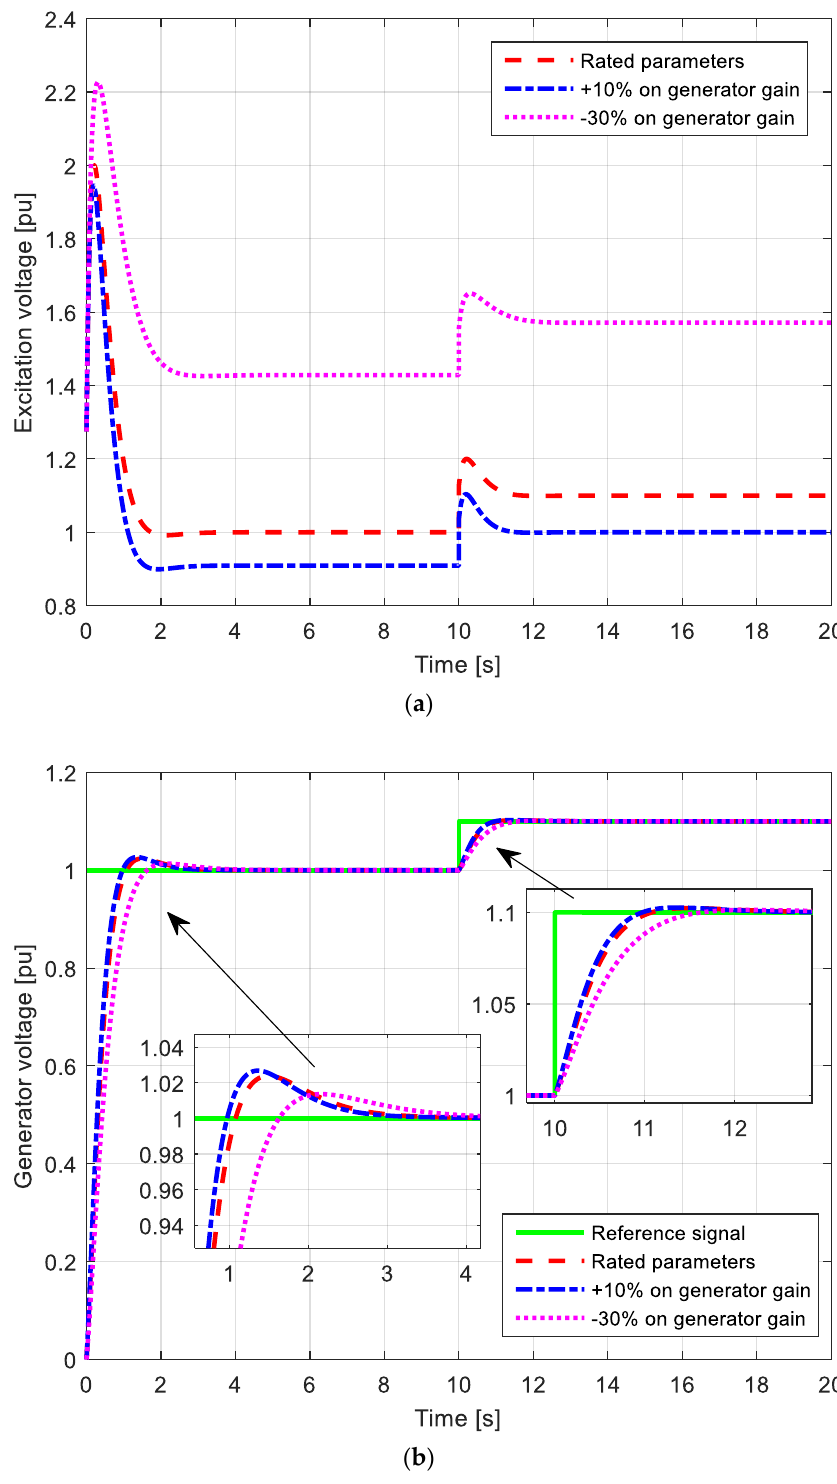
Figure 15. Generator gain variation. ( a ) Excitation and ( b ) generator voltage responses.